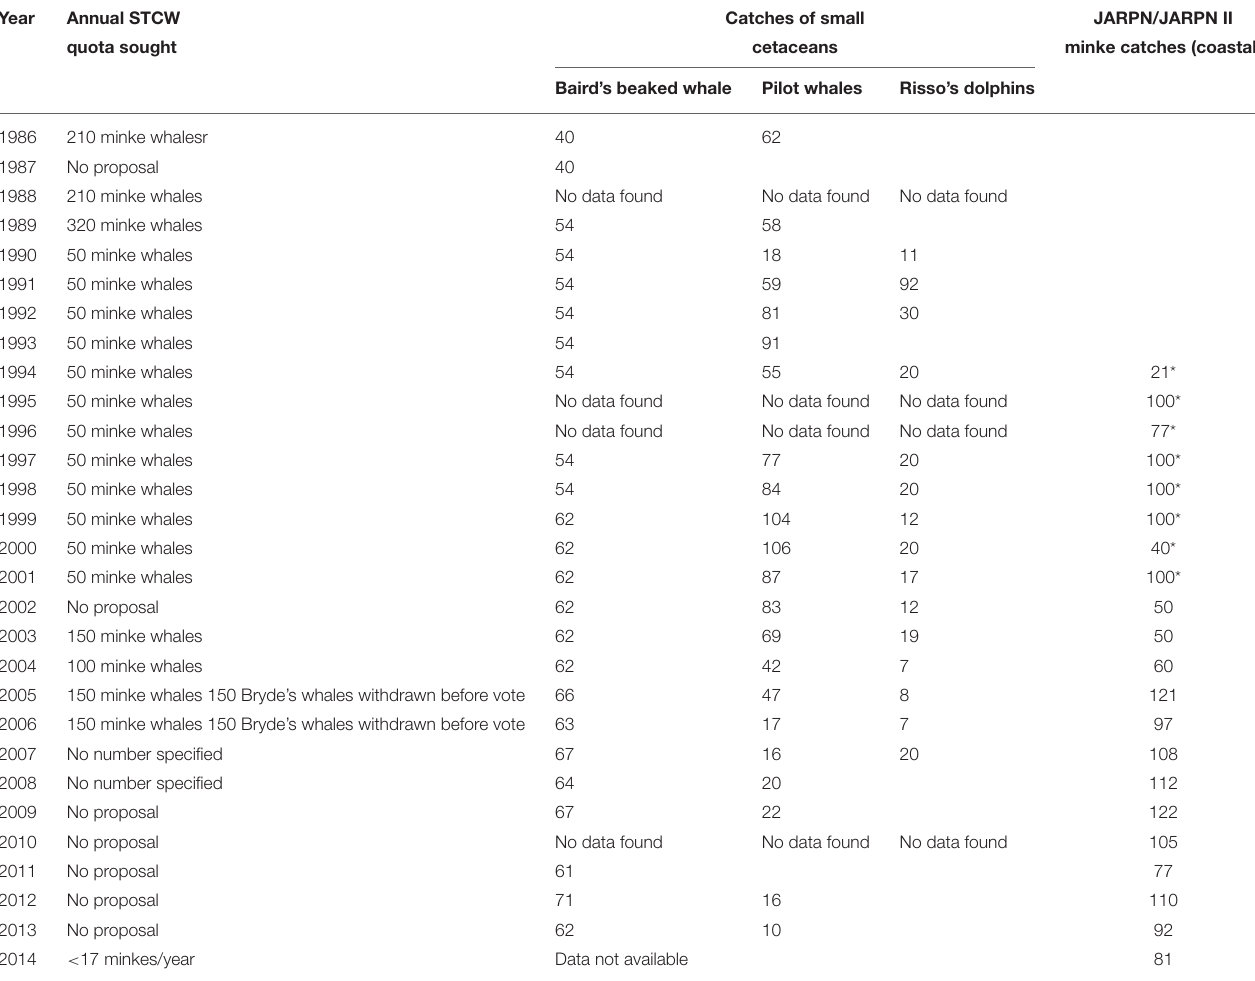
TABLE 1 | STCW requests, catches of small cetaceans by STCW operations and minke whale catches in JARPN/JARPN II since the moratorium came into